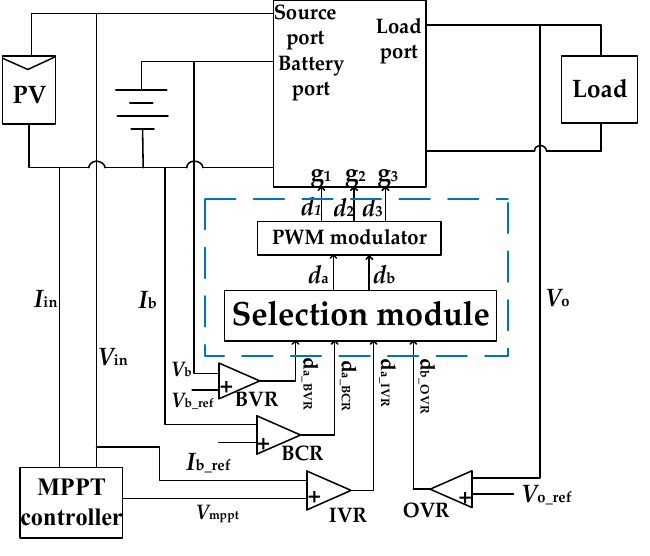
Figure 10. Control block diagram.